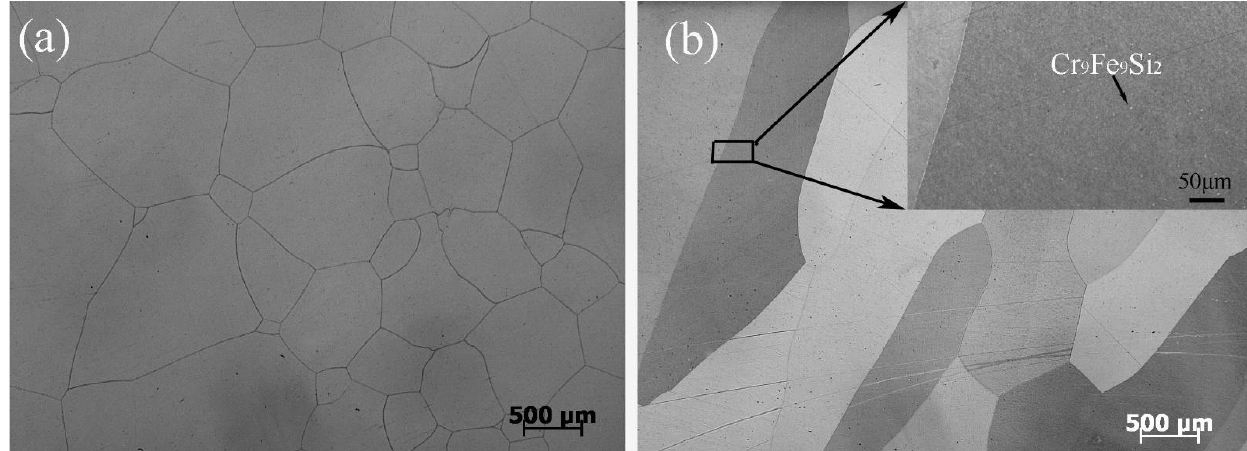
Figure 2. Optical microscopies of Fe-5Cr-5Si ( a ) and Fe-10Cr-5Si ( b ). Table 2. Nominal and actual composition (wt.%/at%) of alloys measured by ICP spectrometry anal- ysis. Nominal Actual